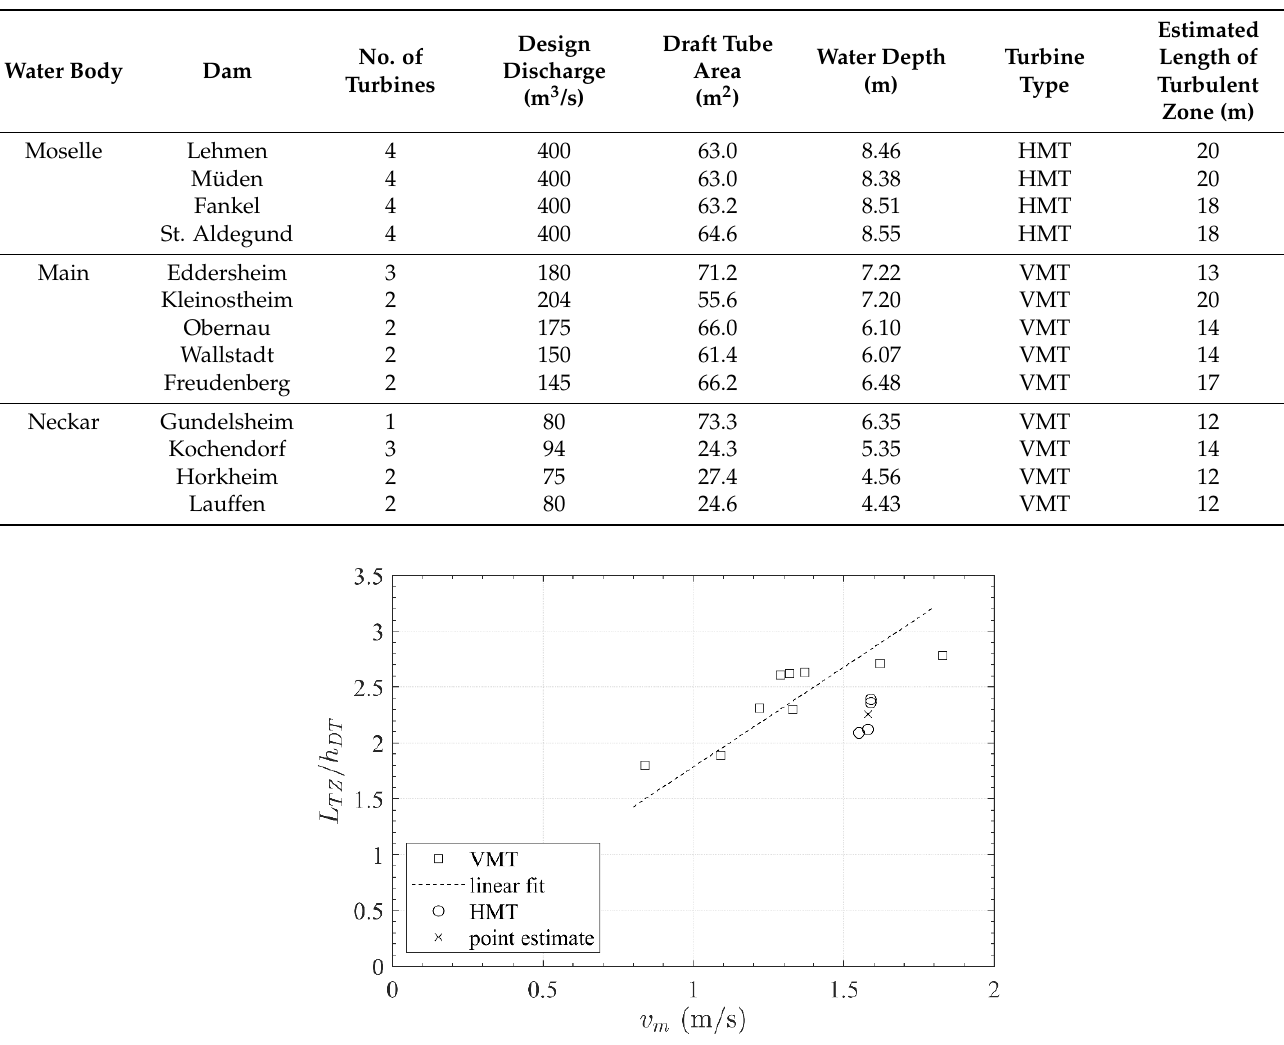
Table 1. Parameters of the inspected dams where the length of turbulent zones were assessed by visual observation; VMT or HMT = vertically or horizontally mounted turbines.